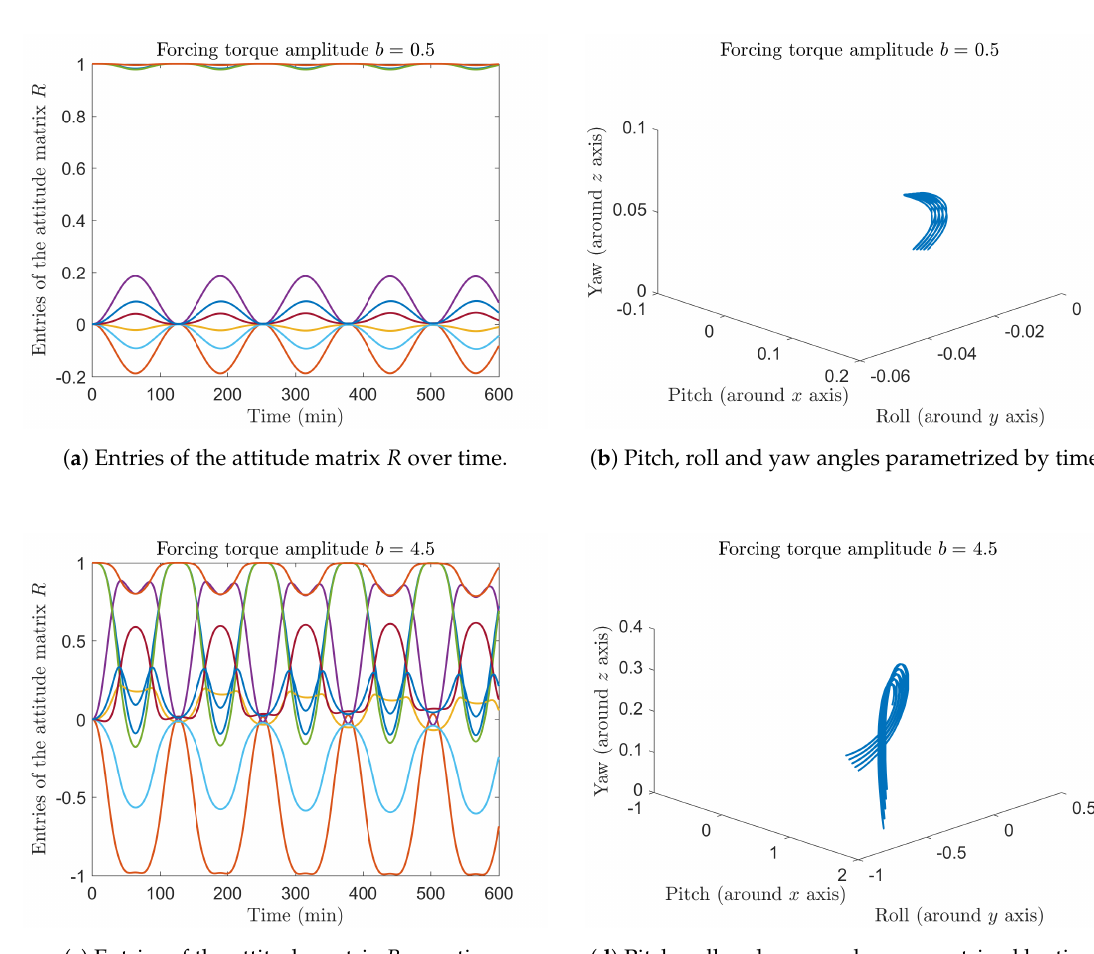
( c ) Entries of the attitude matrix R over time. ( d ) Pitch, roll and yaw angles parametrized by time. Figure 4. Numerical experiment: Trajectory of a satellite gyrostat. (The angles are expressed in radians.)